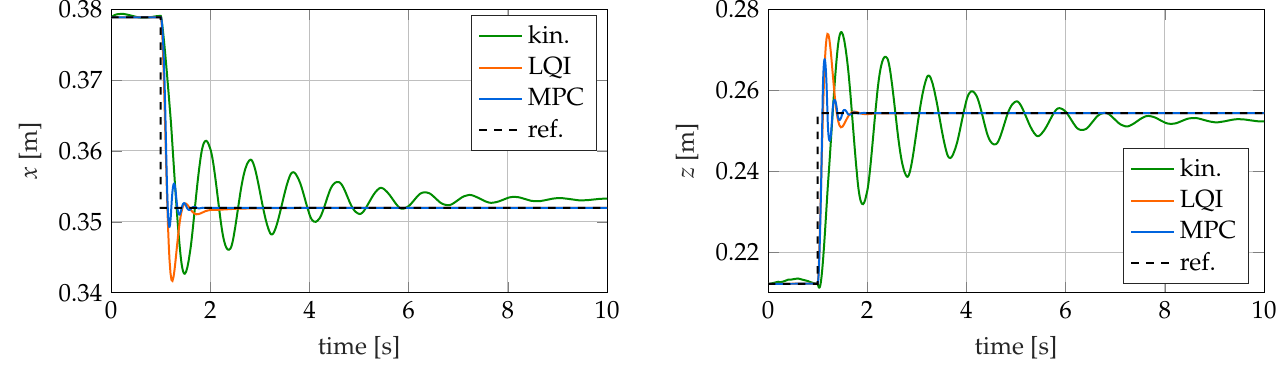
Figure 11. Reference trajectory as well as the tip position for different controllers with d step = 50mm over time. Table 3. Characteristic quantities of the step trajectory with d step = 50mm. Kinematic LQI MPC rise time (10% . . .